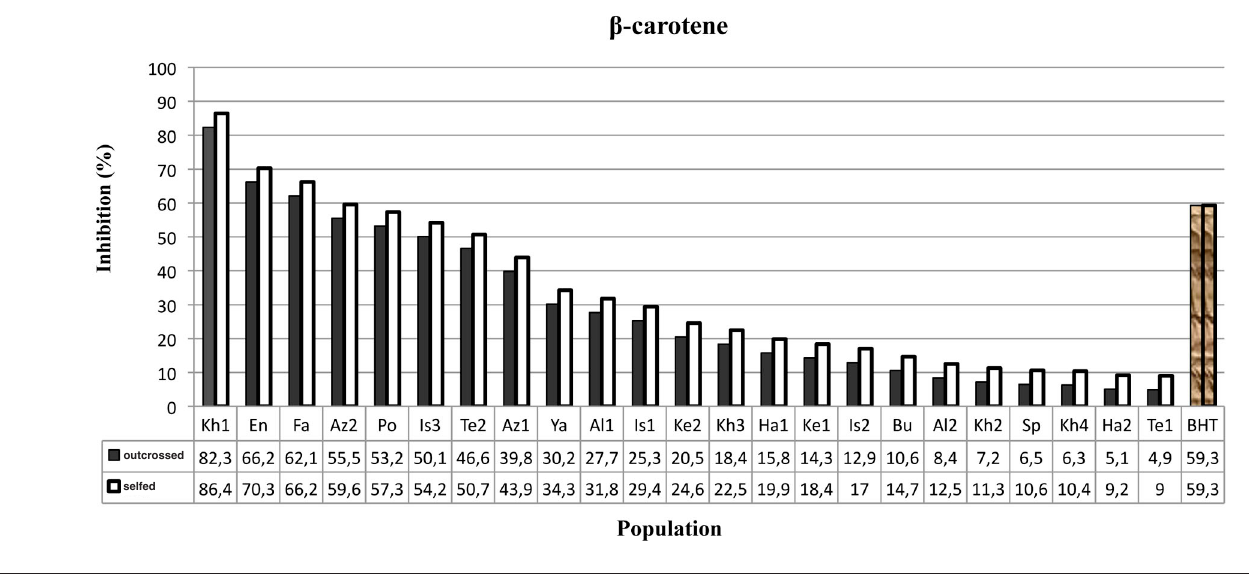
Fig. 5: Inhibitory effect of outcross and self-pollinated population fennel extracts on β-Carotene bleaching